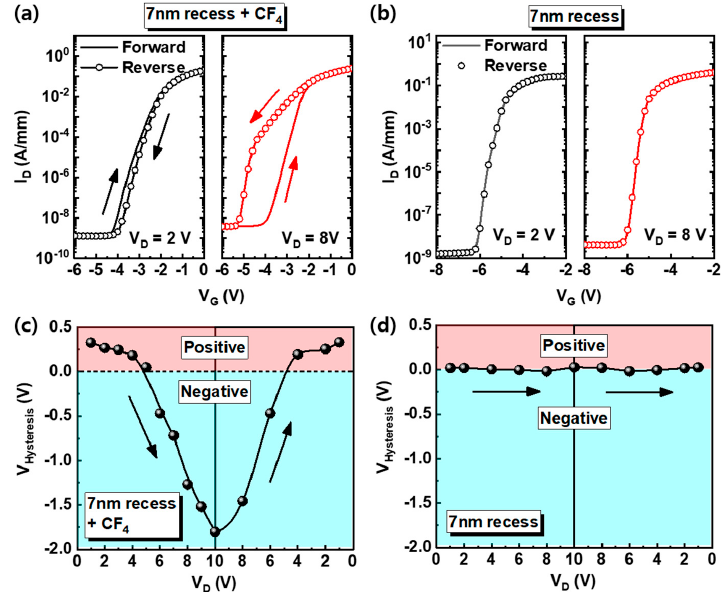
Figure 3. ( a , b ) The I-V hysteresis curves of 7-nm recess + CF 4 and 7-nm recess devices measured at V D = 2 V and 8 V, respectively. The solid line and circle line indicate the forward and reverse sweep, respectively. ( c , d ) The voltage di ff erence of 7-nm recess + CF 4 and 7-nm recess devices by hysteresis at various V D . Red and blue regions show the positive and negative direction of hysteresis,